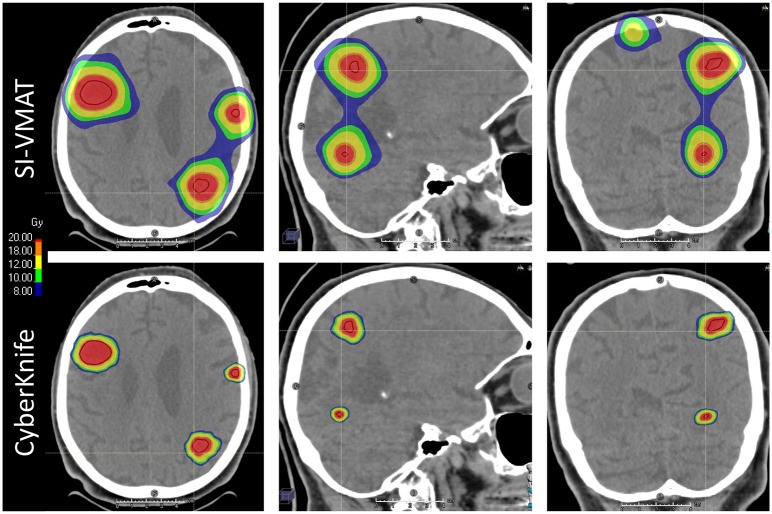
Multiplanar visualization of dose distribution compared between CyberKnife radiosurgery and single-isocenter volumetric modulated arc therapy (SI-VMAT) for a representative case; gross tumor volume (GTV) delineated in dark red. SI-VMAT, single-isocenter volumetric modulated arc therapy.